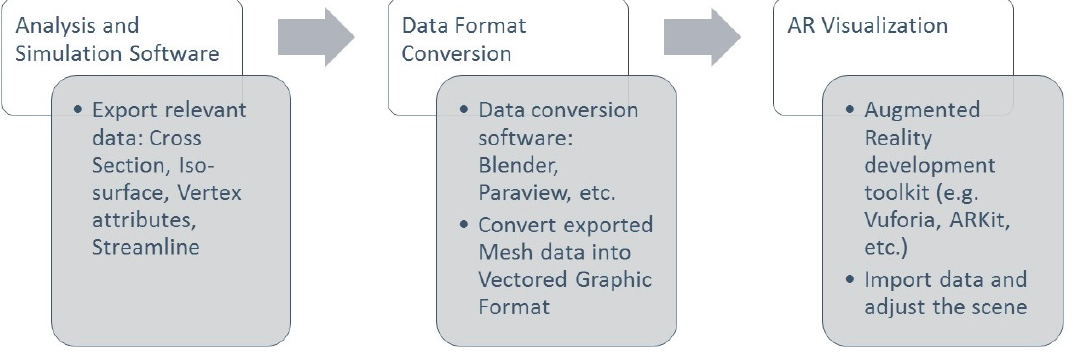
Figure 4. Simulation data conversion procedure.